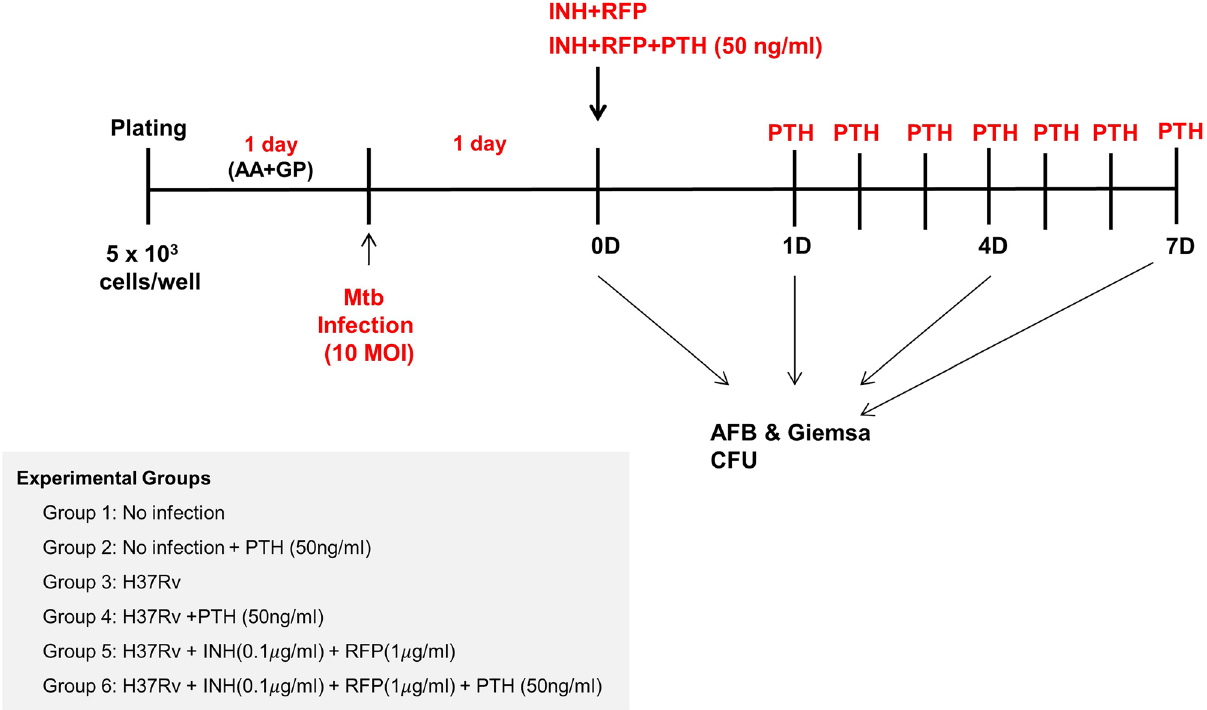
Figure 7. Experimental protocol for infecting MG-63 osteoblasts with Mycobacterium tuberculosis (Mtb) and cotreatment of cells with anti-tuberculosis drugs and teriparatide. Abbreviations: AA, ascorbic acid; AFB, acid- fast bacilli; CFU, colony-forming units; FACS, fluorescence-activated cell sorting; GP, β -glycerophosphate; INH, isoniazid; PTH, teriparatide; RFP,